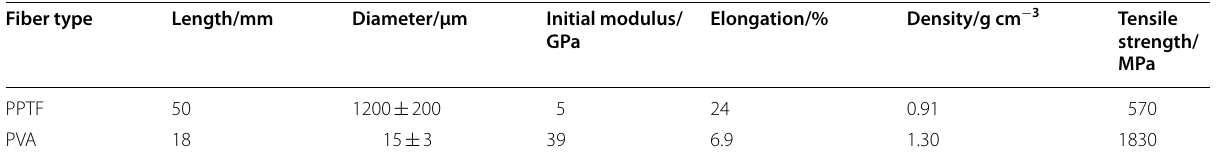
Table 1 Basic performance indices of fiber.